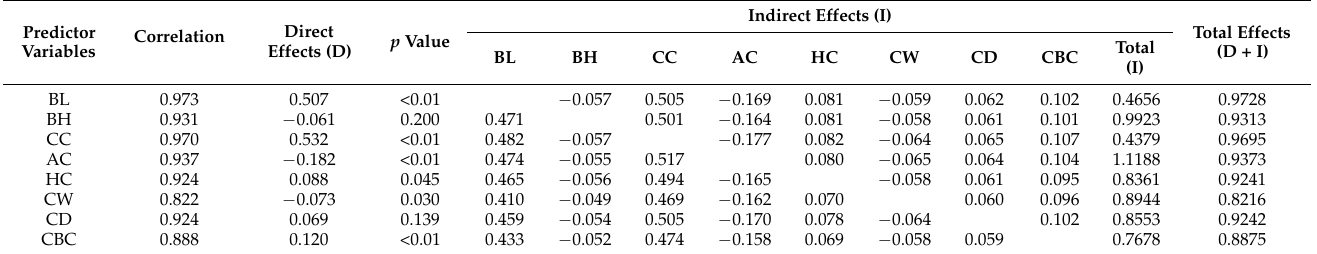
Table 3. Path coefficients for direct and indirect effects of body size indexes on body weight in 10–60 kg stage.